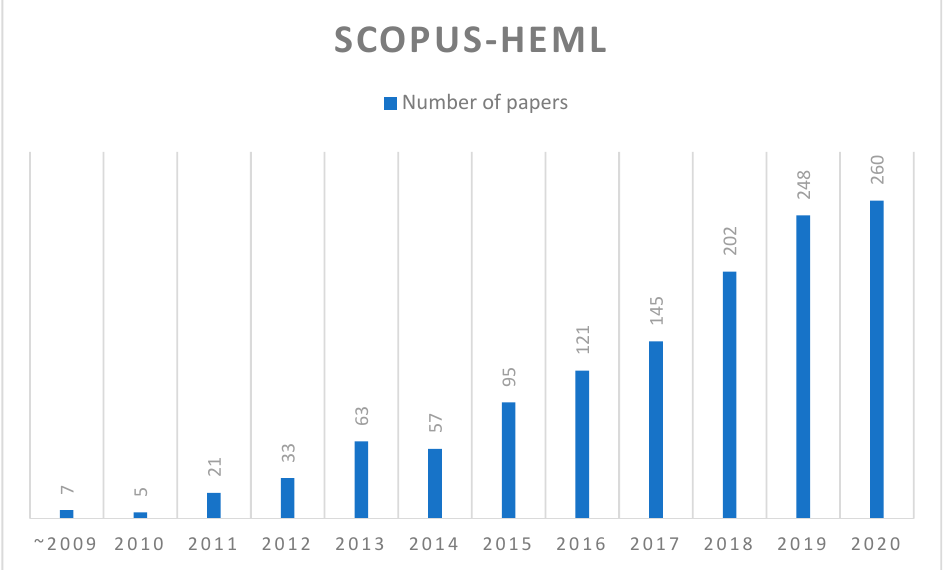
Figure 3. Statistics of papers over the years.